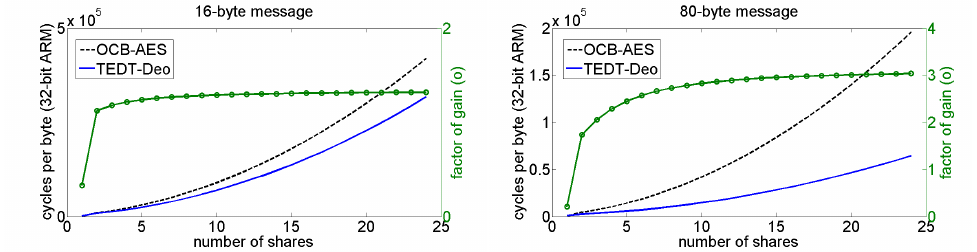
Figure 9: Performance estimations (I): uniformly masked implementation of OCB based on the AES versus leveled implementation of TEDT based on Deoxys-BC-256